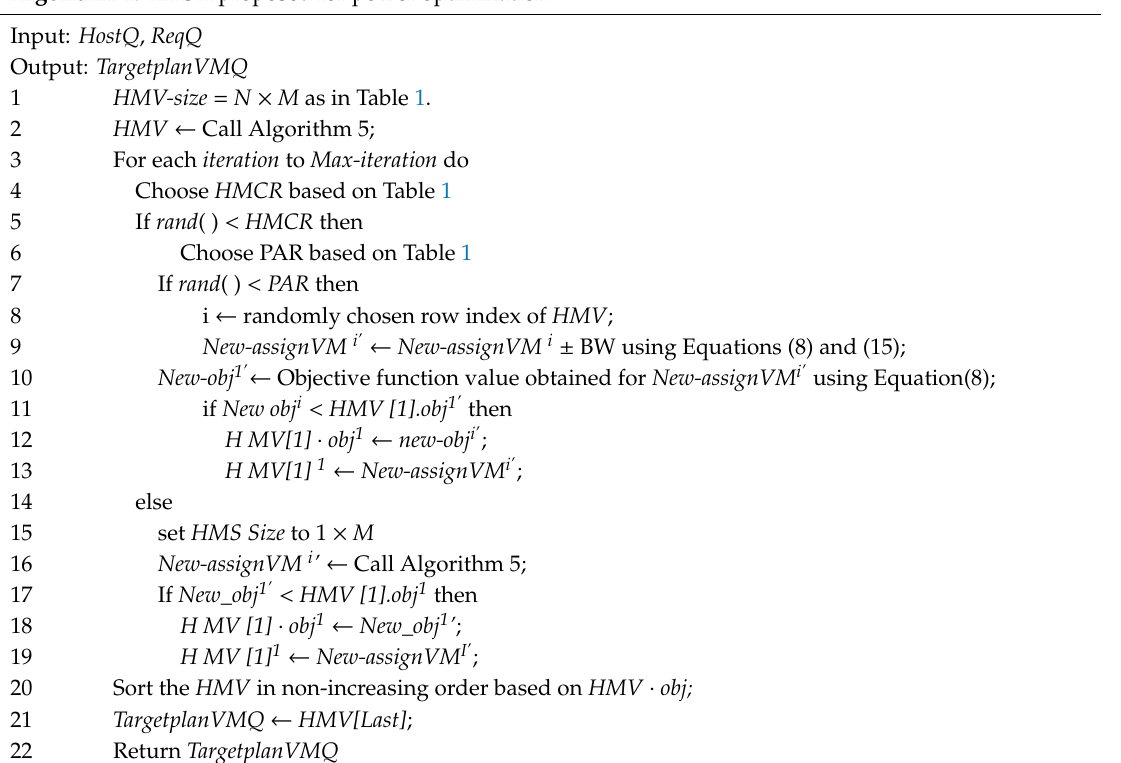
Algorithm 4: AHSA proposed for power